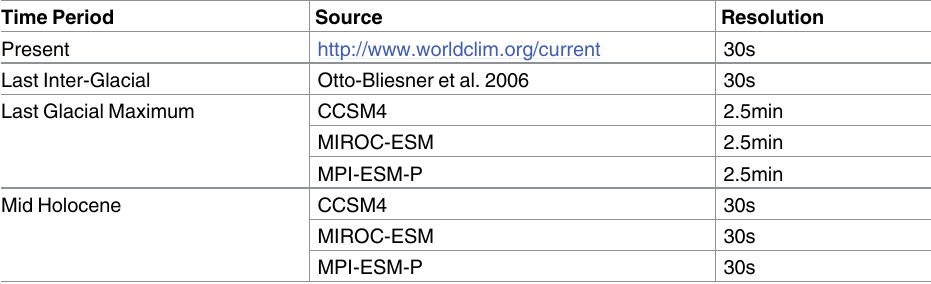
Table 2. General circulation models (GCMs) tested during ENM